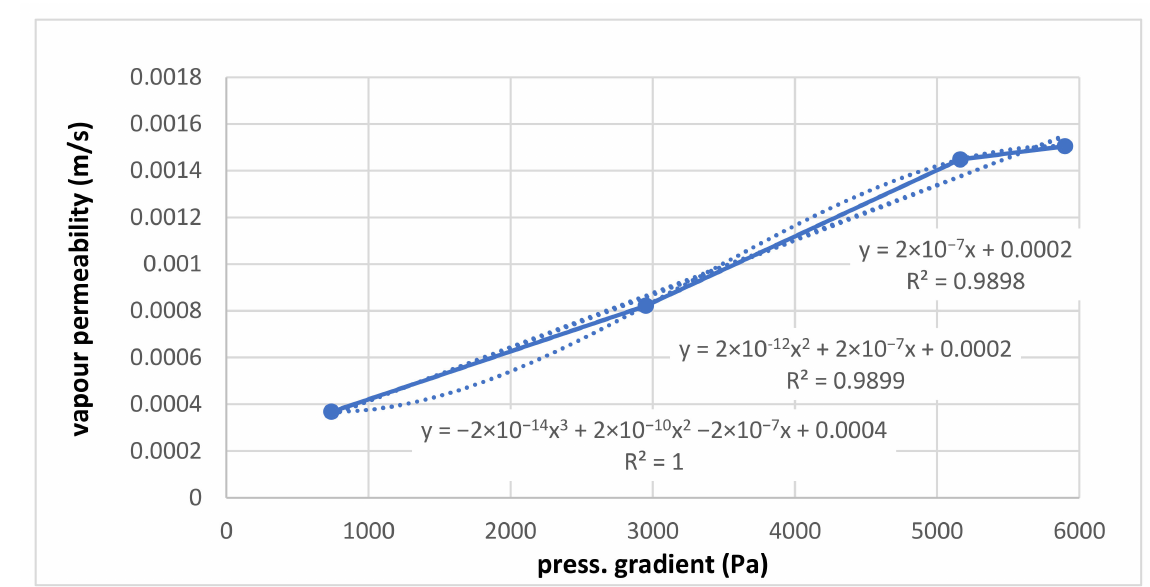
Figure 10. Water vapour permeability at different pressure gradients.